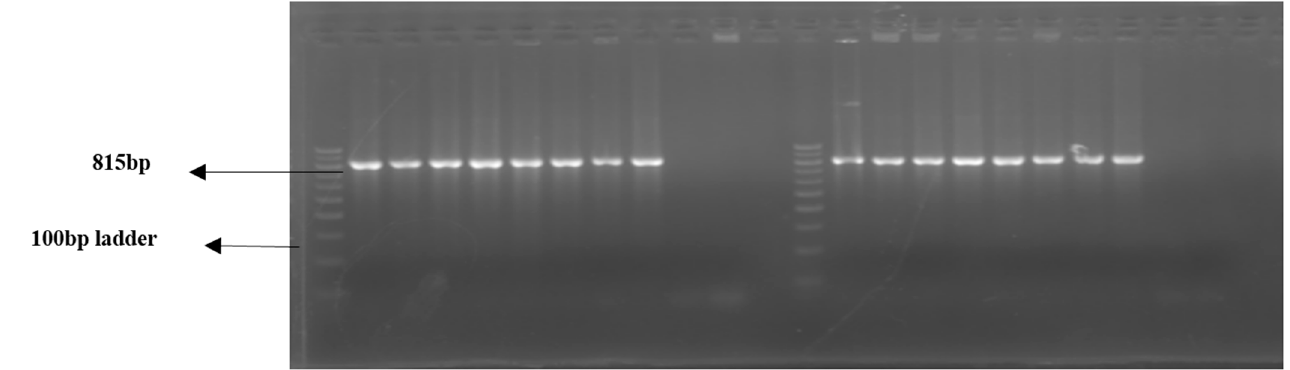
J. Clin. Med. 2022 , 11 , x FOR PEER REVIEW Figure 8. Pattern of PCR amplification product of the specific IL17A gene fragment (815 bp).